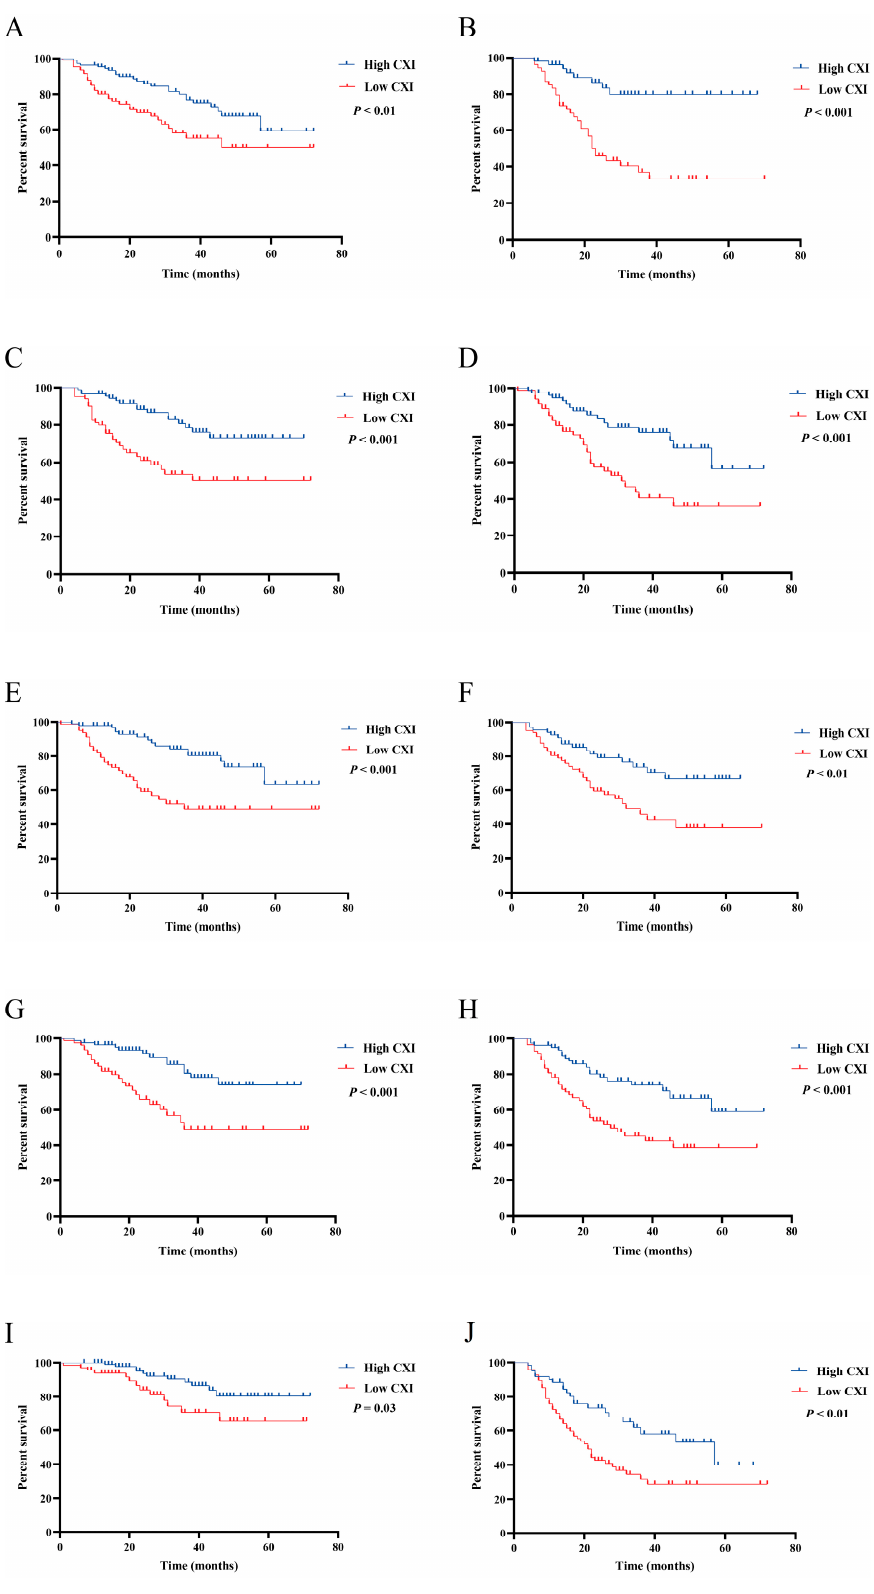
Figure 3. Comparison of OS between patients with low cachexia index and high cachexia index in ( A ) male; ( B ) female; ( C ) patients < 60 years old; ( D ) patients ≥ 60 years old; ( E ) patients without cachexia; ( F ) patients with cachexia; ( G ) patients with BMI ≥ 22.32; ( H ) patients with BMI < 22.32; ( I ) patients with TNM stage I+II; ( J ) patients with stage III+IV.